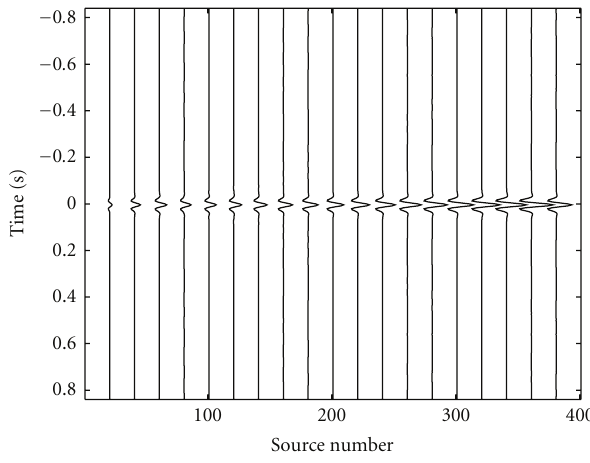
Figure 23: PSF for a virtual source at x A = (15000m,4000m); the red-blue plot is clipped at 20% of the maximum amplitude; the black and green traces represent true-amplitude temporal and spatial traces, respectively.